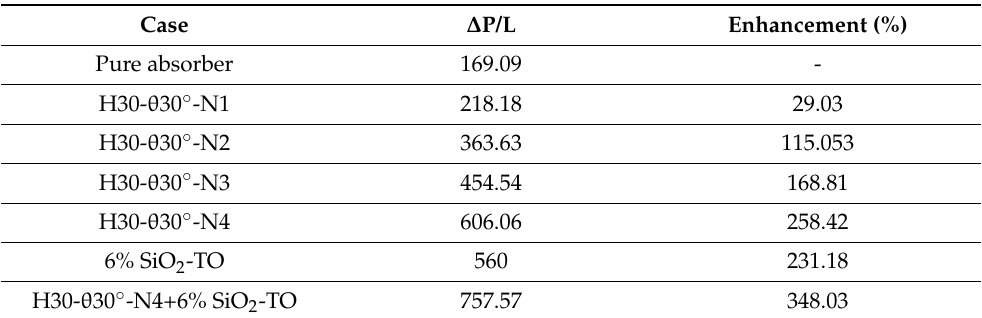
Table 7. Hydraulic enhancement in t pressure drop for single and multiple conical inserts with and without